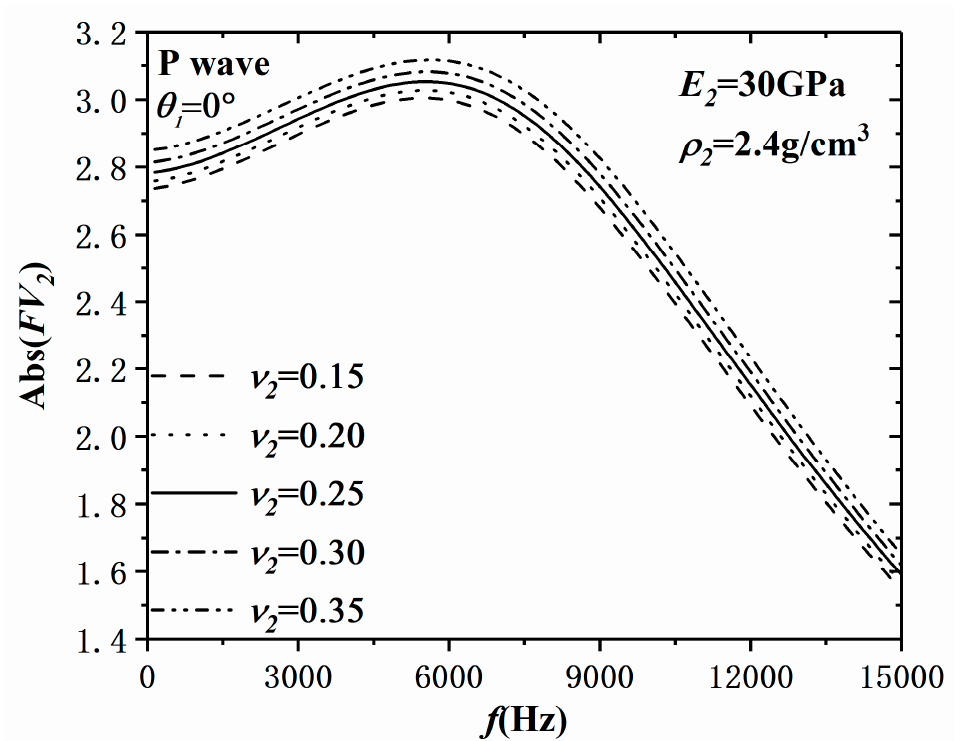
Figure 4. Influence of Poisson’s ratio of the expansive grout on the theoretical amplitude spectrum of gauge combination FV 2 for the incident P wave.